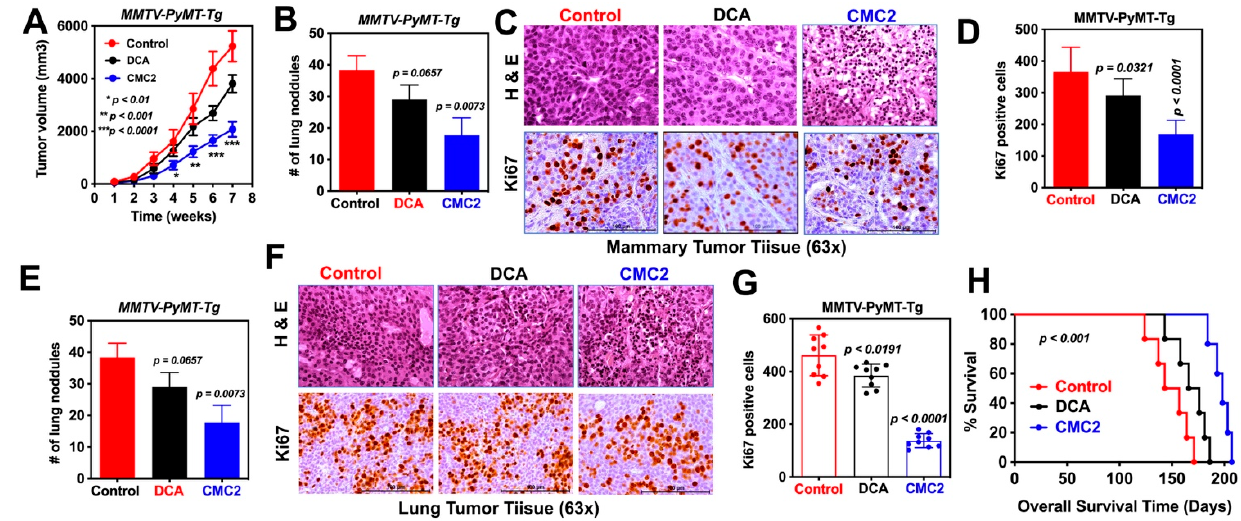
Figure 7. CMC2 treatment inhibits tumor growth in spontaneous mouse mammary tumor models. Six-week-old MMTV–PyMT–Tg mice were treated with DCA and CMC2 (10 mg/kg body for 3× a week for 7 weeks. Control mice received PBS. ( A ) Tumor size was measured twice a week and tumor volume was calculated as described in our previous manuscript [31]. After seven weeks, mice were euthanized, tumor tissue was collected, and measured tumor weight ( B ). Tumor tissue sections were prepared and stained with H&E, and Ki67- and Ki67-positive cells were quantitated manually ( C , D ). Lung tissues were collected, visible lung nodules were manually counted ( E ). Lung tissue sections were prepared and stained with H&E and Ki67. The density of Ki67-positive cells per objective field was manually counted ( F , G ). Finally, we monitored the overall survival ( H ). Values are shown as mean ± SD of six mice in each group.